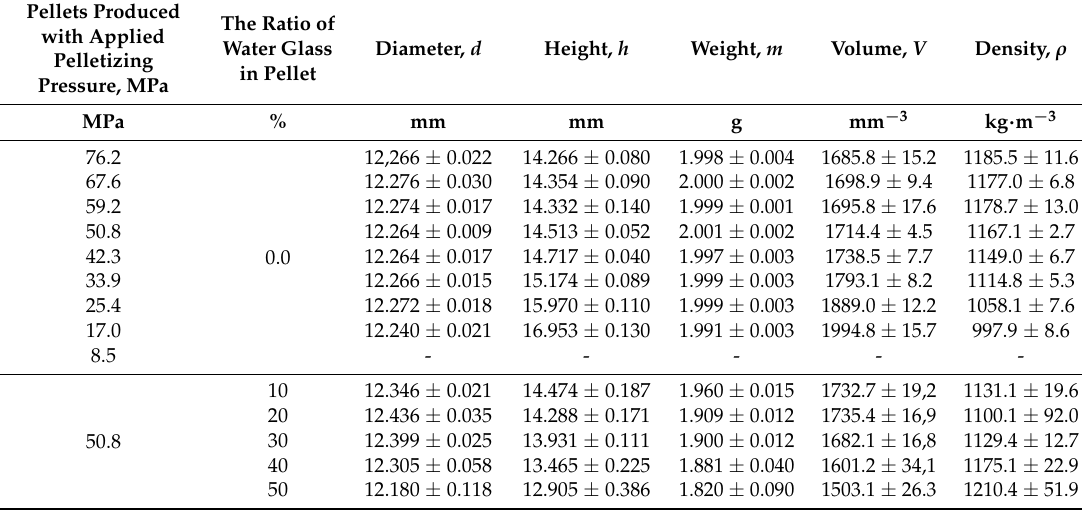
Table 4. Dimensions, weight, and density of carbonized refuse-derived fuel (CRDF) pellets produced at pressures from 8.5 MPa to 76.2 MPa, and CRDF pellets produced with a pressure of 50.8 MPa with the addition of water glass content ranging from 10% to 50% as a binder, mean ± standard deviation, n =